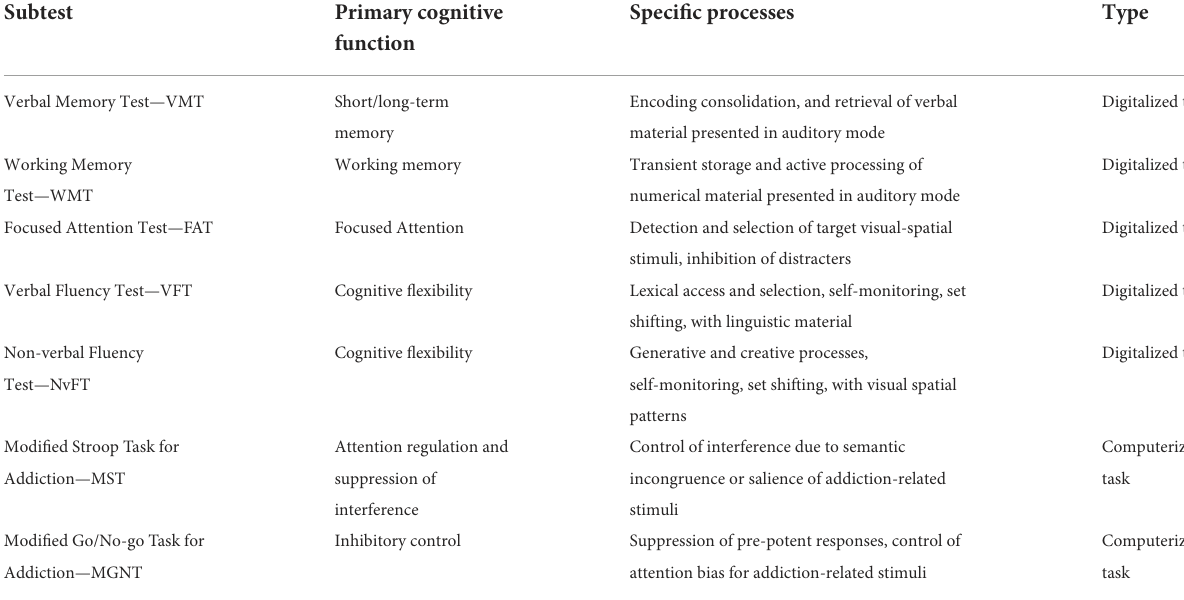
TABLE 1 Structure of BFE-A subtests, cognitive functions and processes investigated by each subtest, and their type.